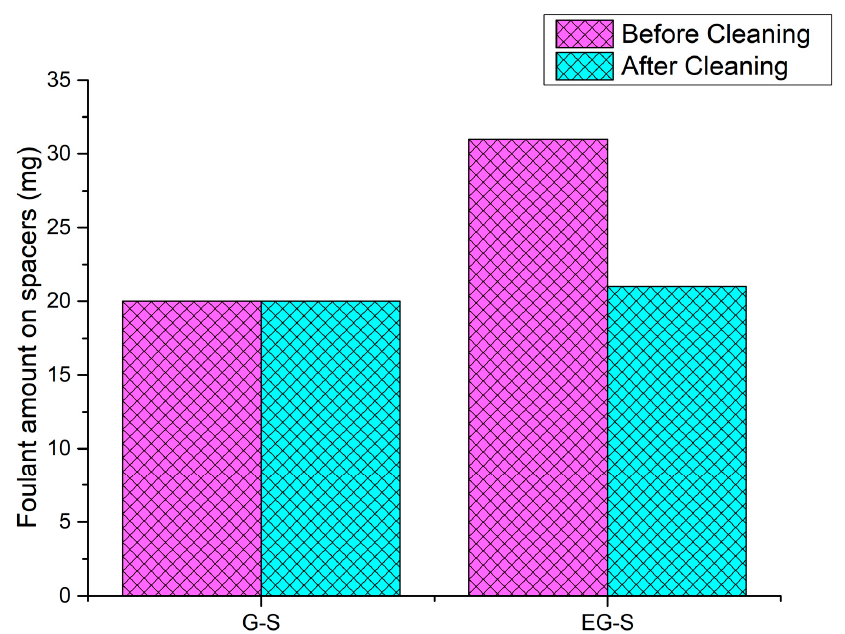
Figure 7. Efficacy of electric polarization on the adsorption of foulants on the G-S and EG-S spacers.